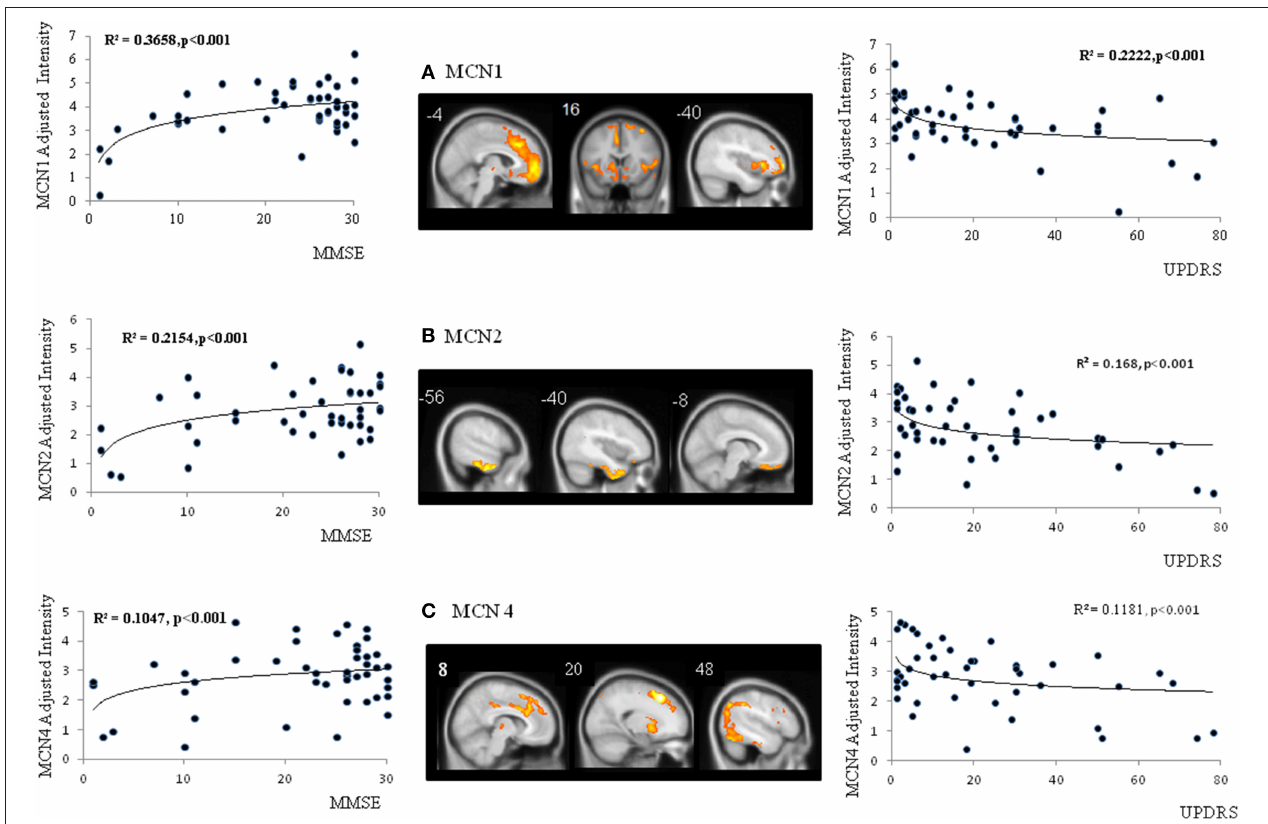
FIGURE 4 | Spatial maps of three significant metabolic covariant networks (MCN) (A–C) and correlations between MCN adjusted intensity and clinical parameters. MMSE, mini-mental state examination; UPDRS, Unified Parkinson’s Disease Rating